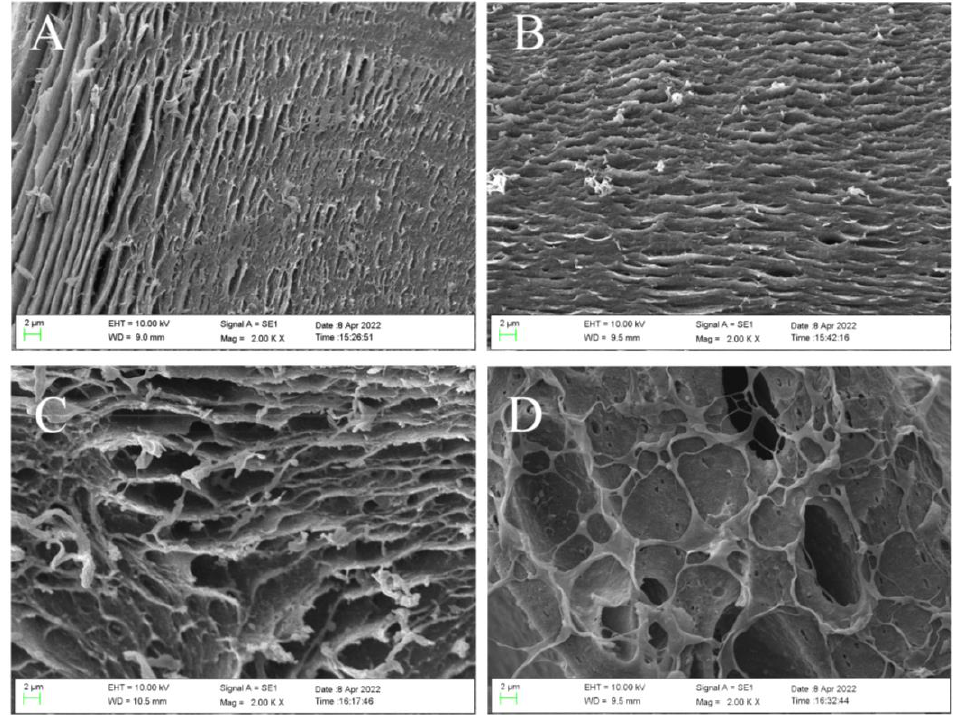
Figure 1. SEM micrograph of internal morphology of SFP/SA-0 ( A ), SFP/SA-20 ( B ), SFP/SA-40 ( C ), and SFP/SA-60 ( D ) at 2000×.